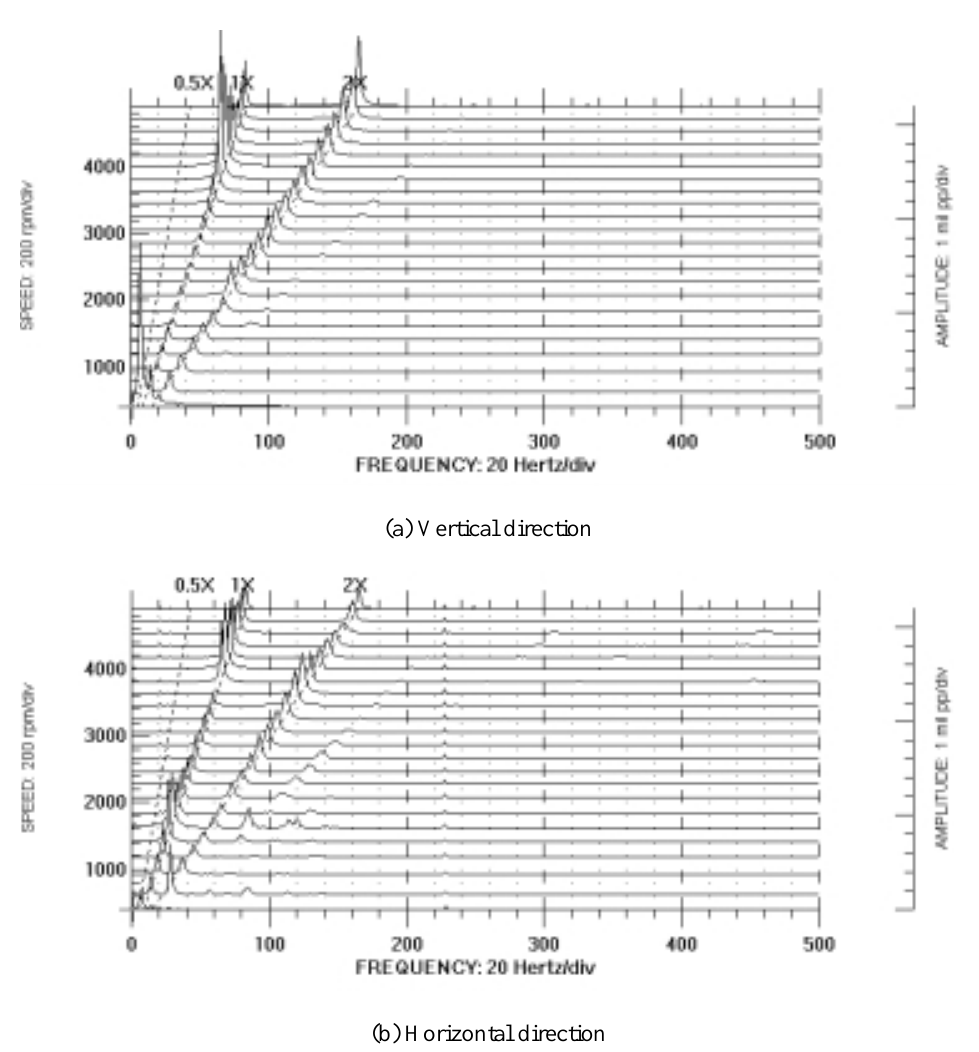
Fig. 7. Frequency cascades of startup data for the 1st shaft with 4 mm notch crack and 8 kg vertical hanging side